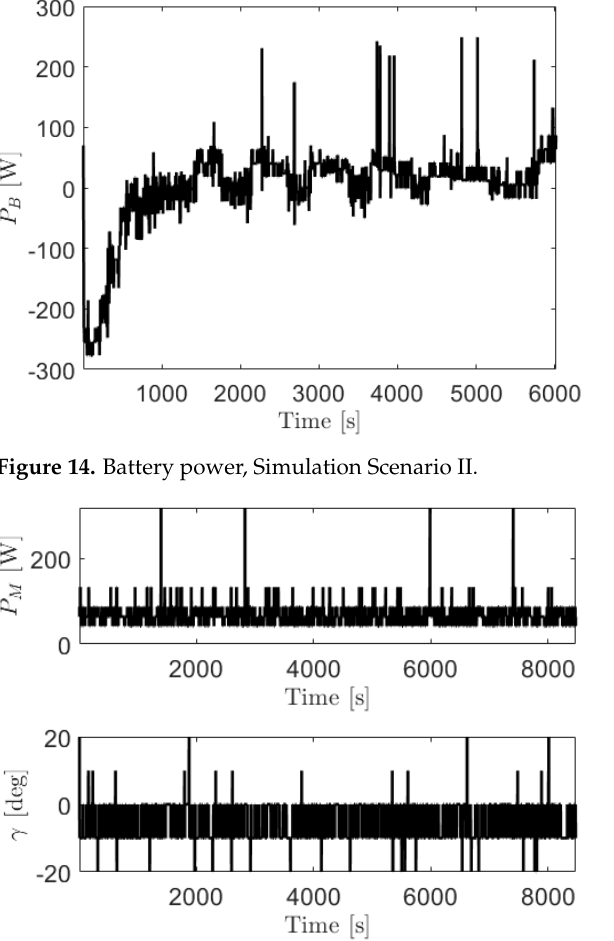
Figure 15. sUAV P M and γ versus time, Simulation Scenario III.